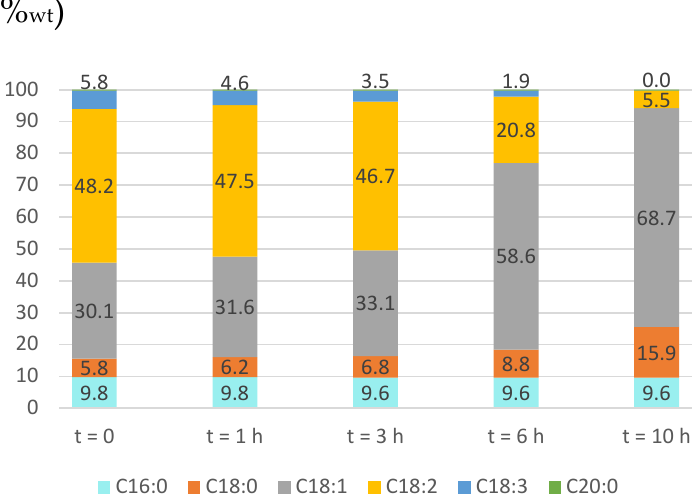
Figure 5. SO FAMEs composition (C) at different reaction times during hydrogenation with Ni-pol (0.059 mmol of Ni), biodiesel (0.5 mmol, 125 mg), and CH 3 OH (5 mL), at 100 ◦ C under H 2 (10 bar). In all of the histograms, the percent of C20:0 methyl ester is equal to 0.3%.